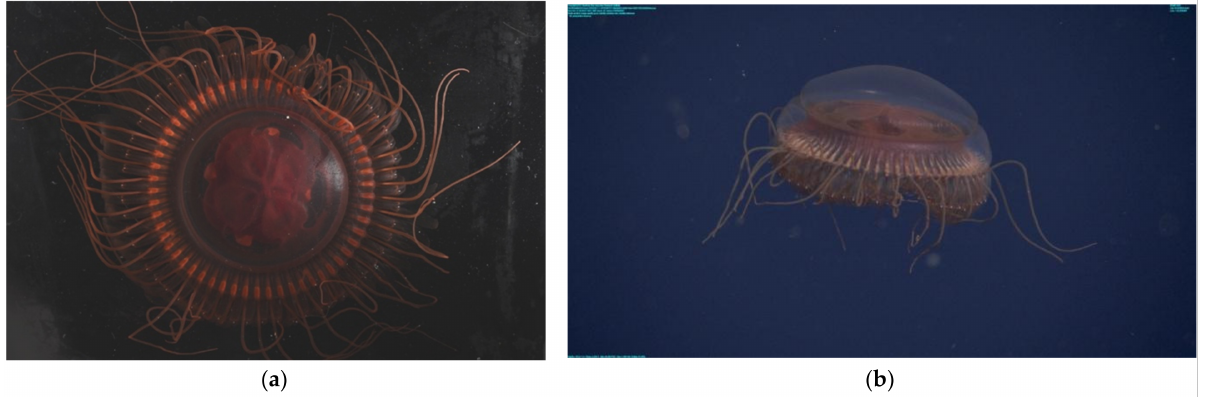
Figure 2. ( a ) Laboratory photo of Atolla species A taken in the lab (photo by SHDH) of the specimen collected on 30 October 2021 (D1399). Diameter from margin to margin (excluding lappets) is 8.5 cm. ( b ) In situ image of Atolla species A (D1402) photographed on 14 November 2021 at a depth of 1913 m, 5.4 cm in diameter.